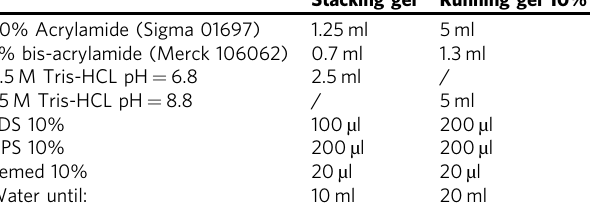
Stacking gel Running gel